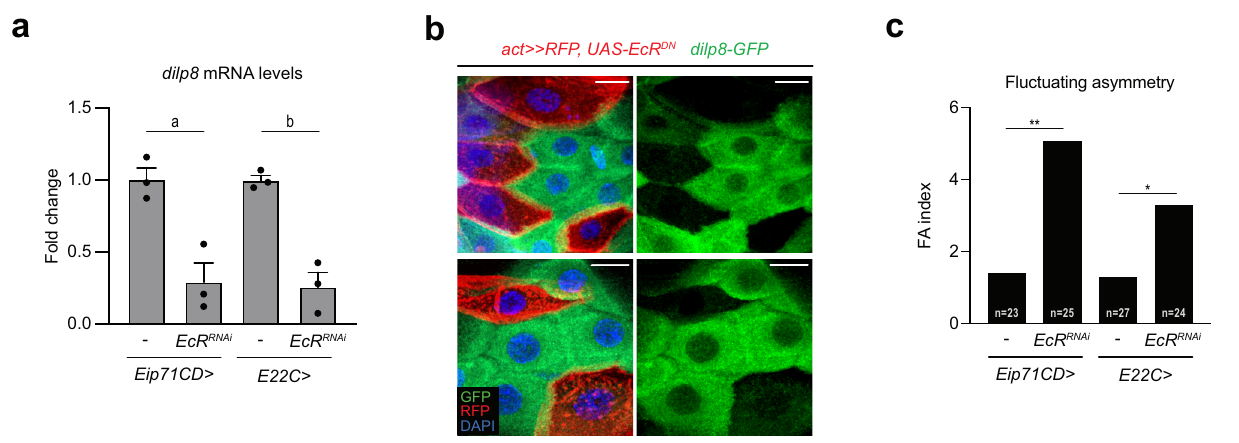
Fig. 4 | Ecdysone signaling induces dilp8 expression in the epidermis. a Measurement of dilp8 mRNA levels by qRT-PCR on whole animals at the WPP stage upon RNAi-mediated downregulation of the ecdysone receptor gene EcR in the epidermis. Values are expressed as fold changes relative to controls without RNAi.ErrorbarsrepresentSEM.a: p =0.0104,b: p =0.0024,two-tailed t -tests. n =3 biologically independent samples were analyzed for all genotypes. b Two repre- sentativeexamplesofepidermisofanimalsattheWPPstageshowingexpressionof the dilp8-GFP reporter in control cells and clones of cells expressing a dominant- negativeisoformof EcR ( EcR DN ;cellsmarkedwithRFPandshowninred).Scalebars